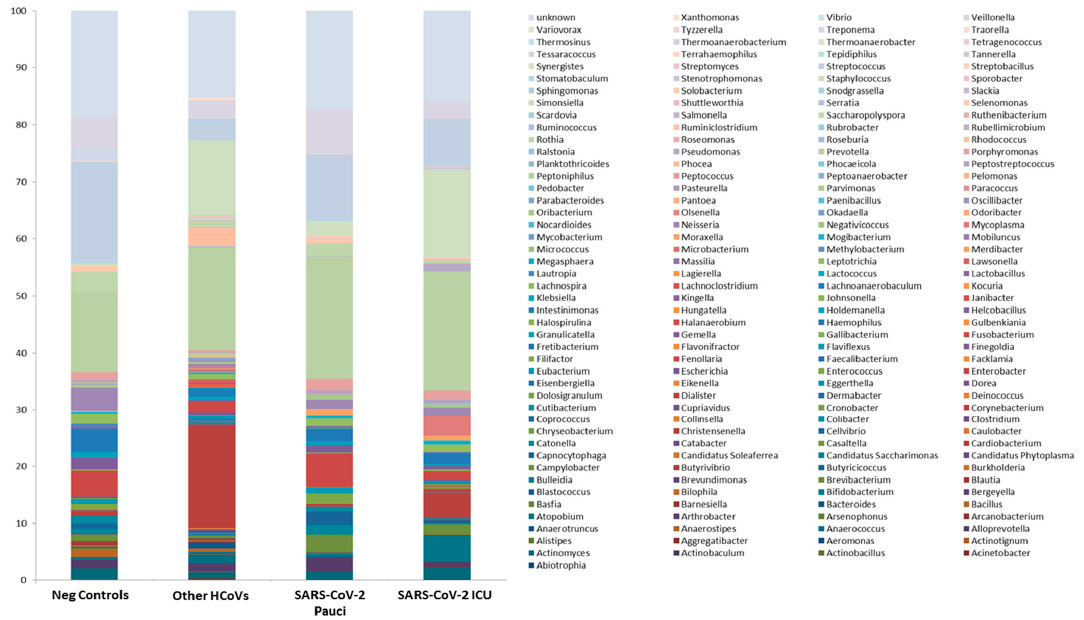
Figure 4. Microbiota composition of Neg Controls, Other HCoVs, SARS-CoV-2 Pauci and SARS-CoV-2 ICU at the genus level. The mean value of all the detected taxa is represented.